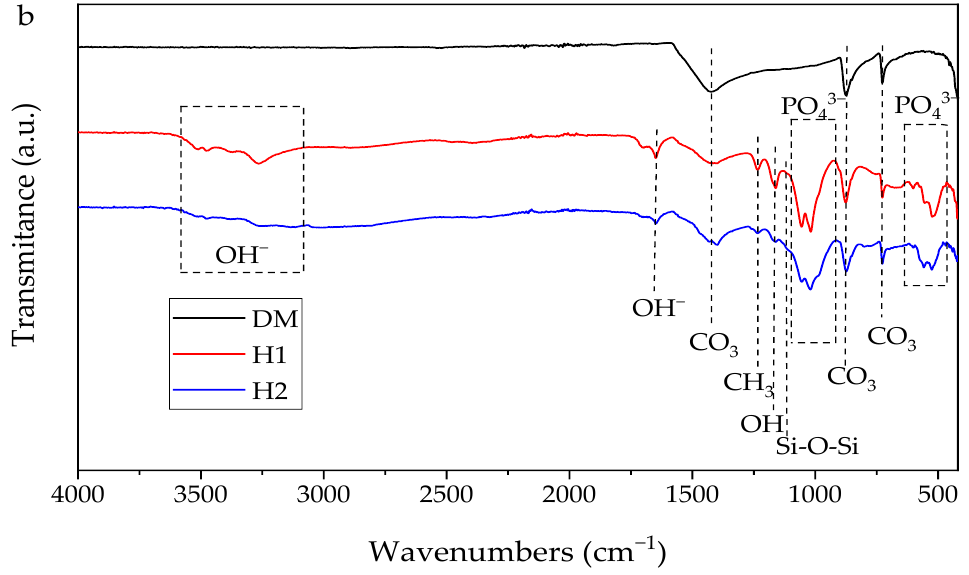
Figure 4. Structure analysis of the specimens: ( a ) Raman spectra; ( b ) FTIR results. The FTIR spectra of specimens before and after treatment are revealed in Figure